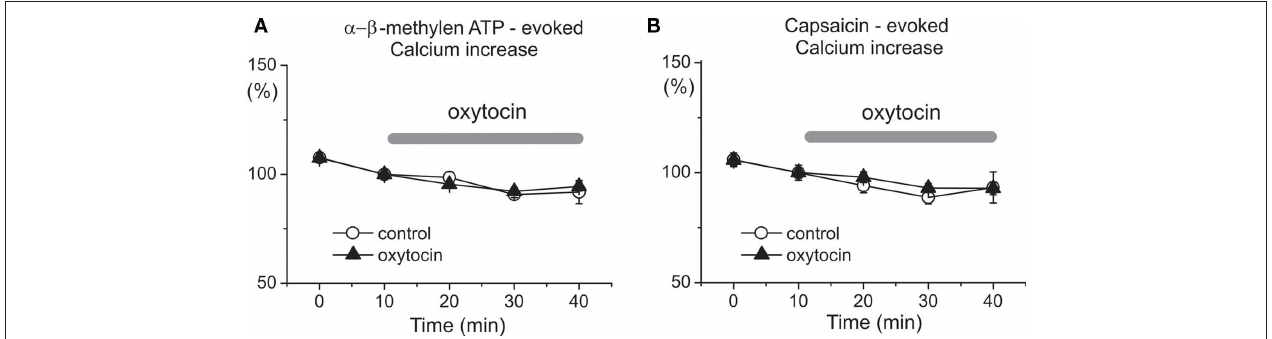
calcium responses under control conditions (open circles; n = 276 and 223 cells for a , b -meATP and capsaicin, respectively) and during oxytocin application (triangles; n = 283 and 248 cells, respectively).